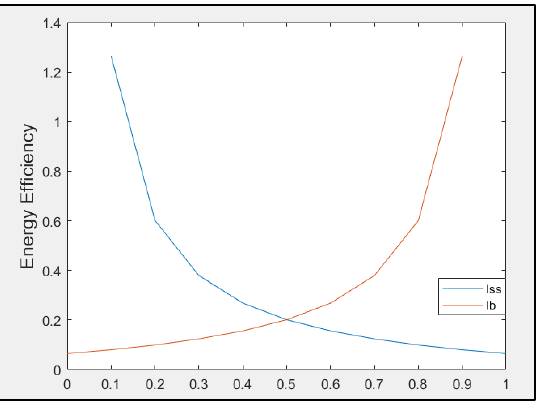
Figure 9. Energy efficiency vs. fraction of sensing energy and harvested energy.